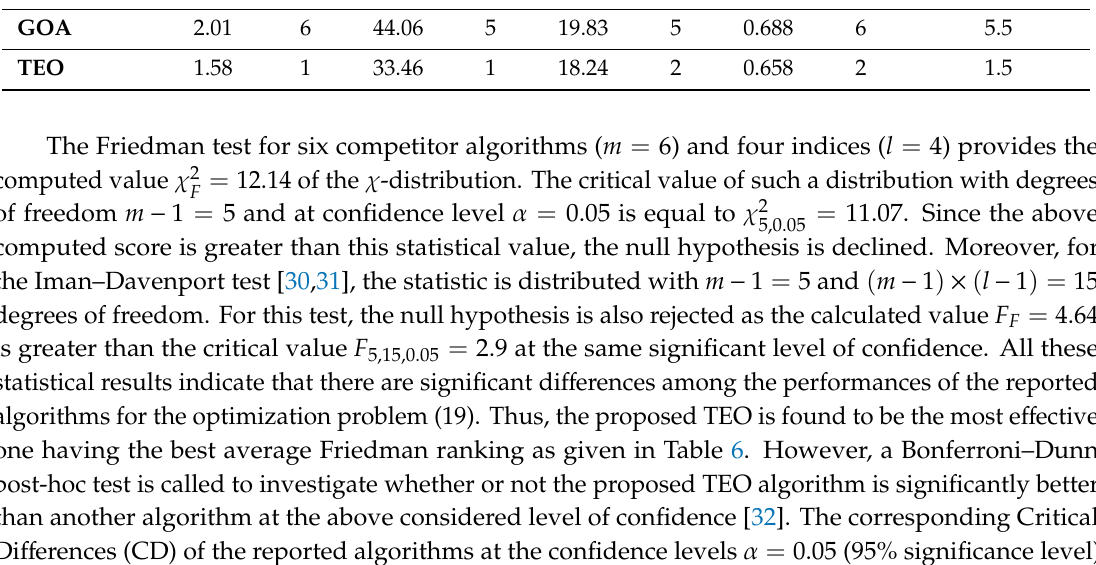
Figure 15. Time-domain variations of the TEO-based control of the direct and quadrature rotor currents.